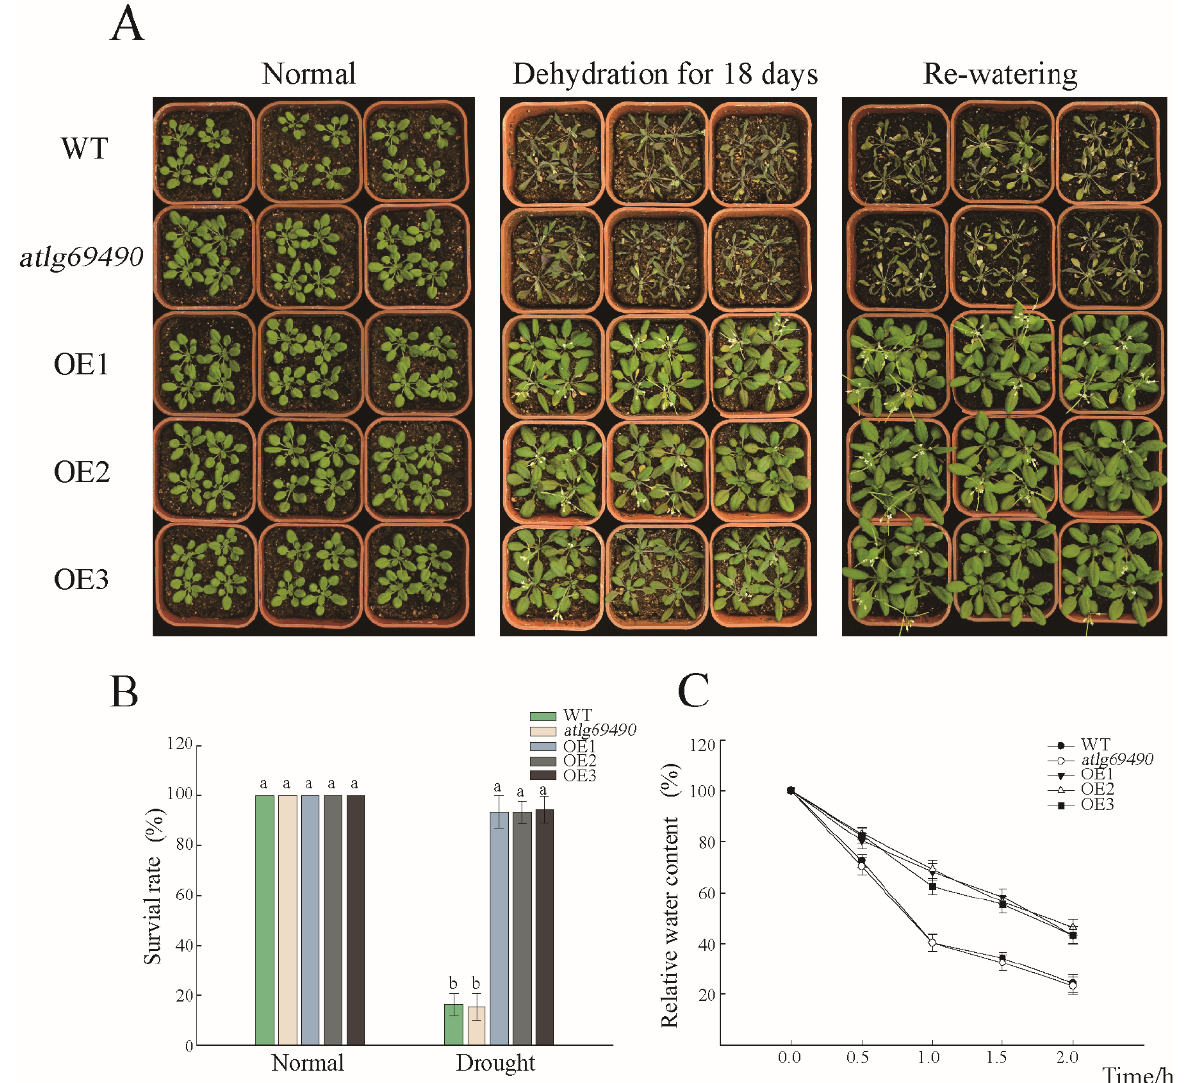
Figure 4. Overexpression of PwNAC38 significantly improved the drought tolerance of Arabidopsis . ( A ) Phenotypes of different PwNAC38 transgenic lines under dehydration treatment. ( B ) Statistics of survival rates after drought treatment. ( C ) Relative water content (RWC) of isolated leaves under dehydration treatment. WT: Wild type; OE line 1, 2, 3: Overexpressing plants; at1g69490 : Mutant plants. The significantly different mean values at p ≤ 0.05 were labeled by different letters.